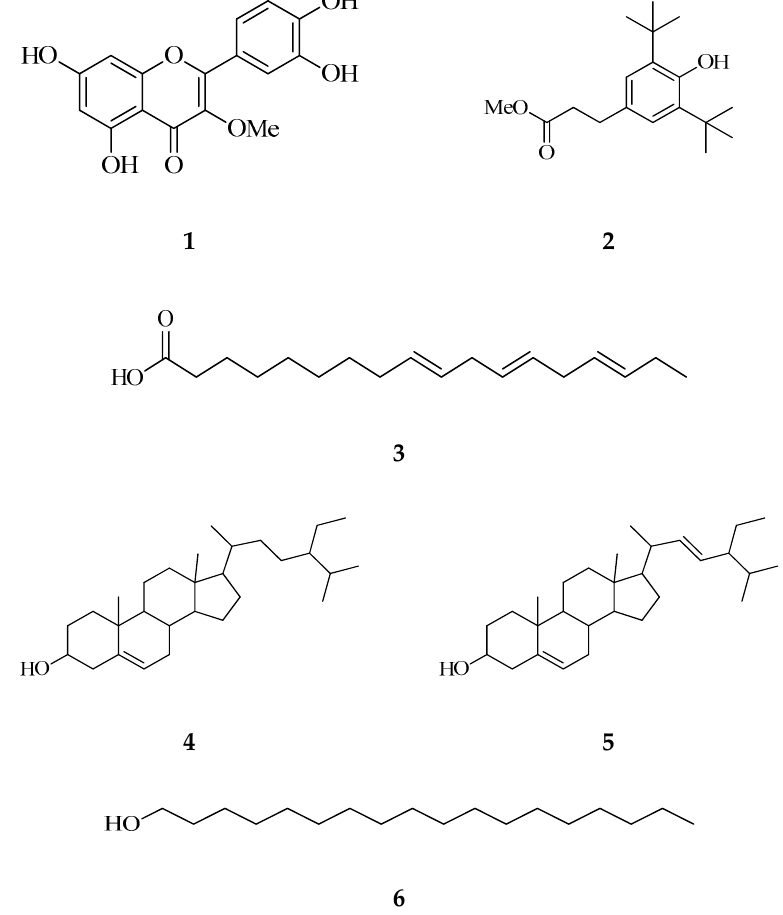
Figure 1. The structures of the isolated compounds; 1 – 6 of C. timorensis leaves and flowers.